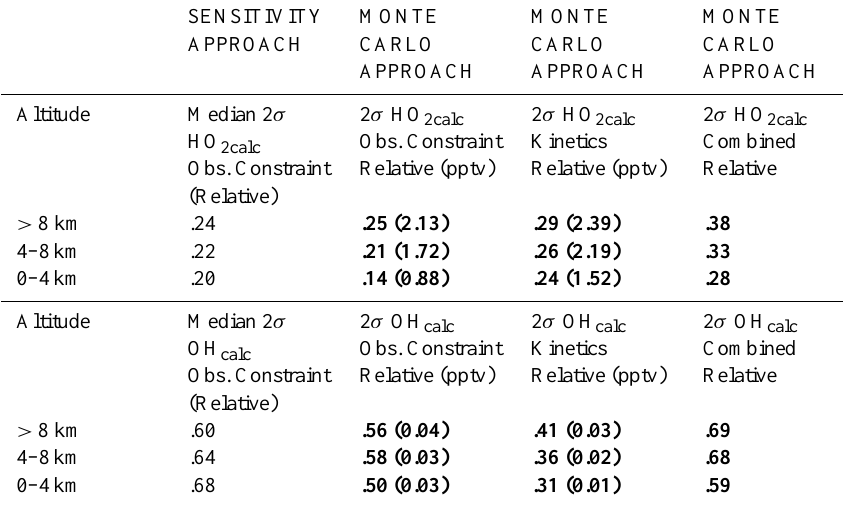
Table A2. 2 σ Uncertainty in model predictions for ARCTAS-A (Fully Constrained Model).